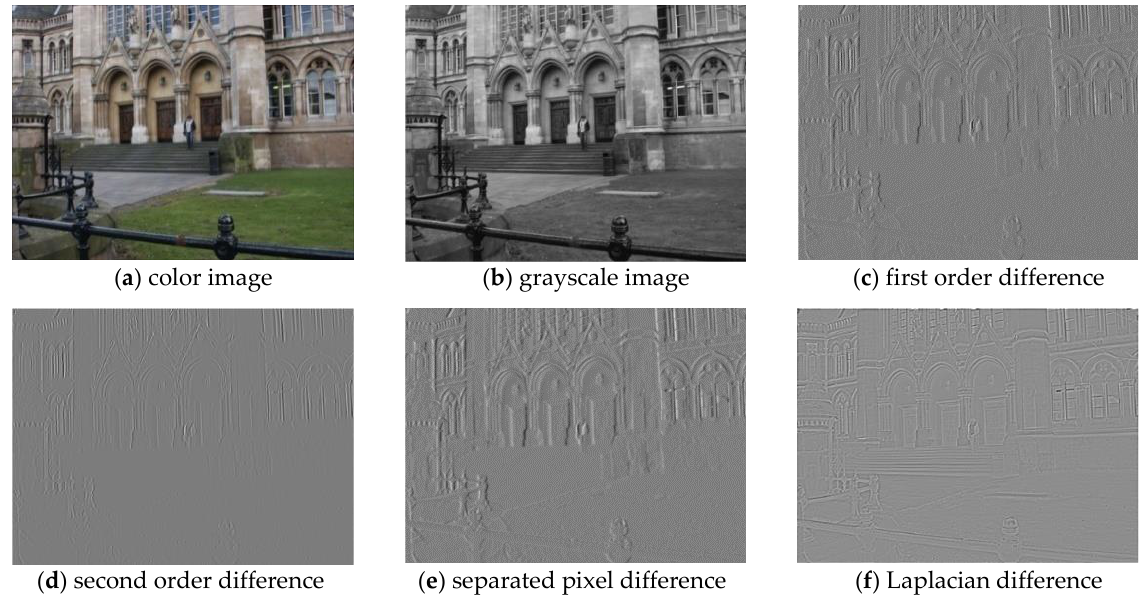
Figure 5. Pixel differences: ( a ) first order pixel difference; ( b ) separated pixel difference; ( c ) nega- tive Laplacian operator.